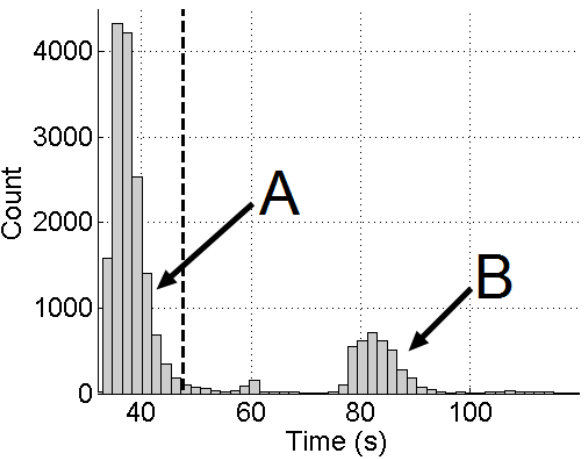
Fig. 8. Histogram of processor time per simulation of the 20000 Monte Carlo simulations. The dashed line denotes the ensemble mean (48s). The bimodal distribution is due to the greater compu- tational requirements of simulations selected to carry forward into transient forcing following spin-up ( B ) in comparison to those that were not selected (i.e. discarded following spin-up; A